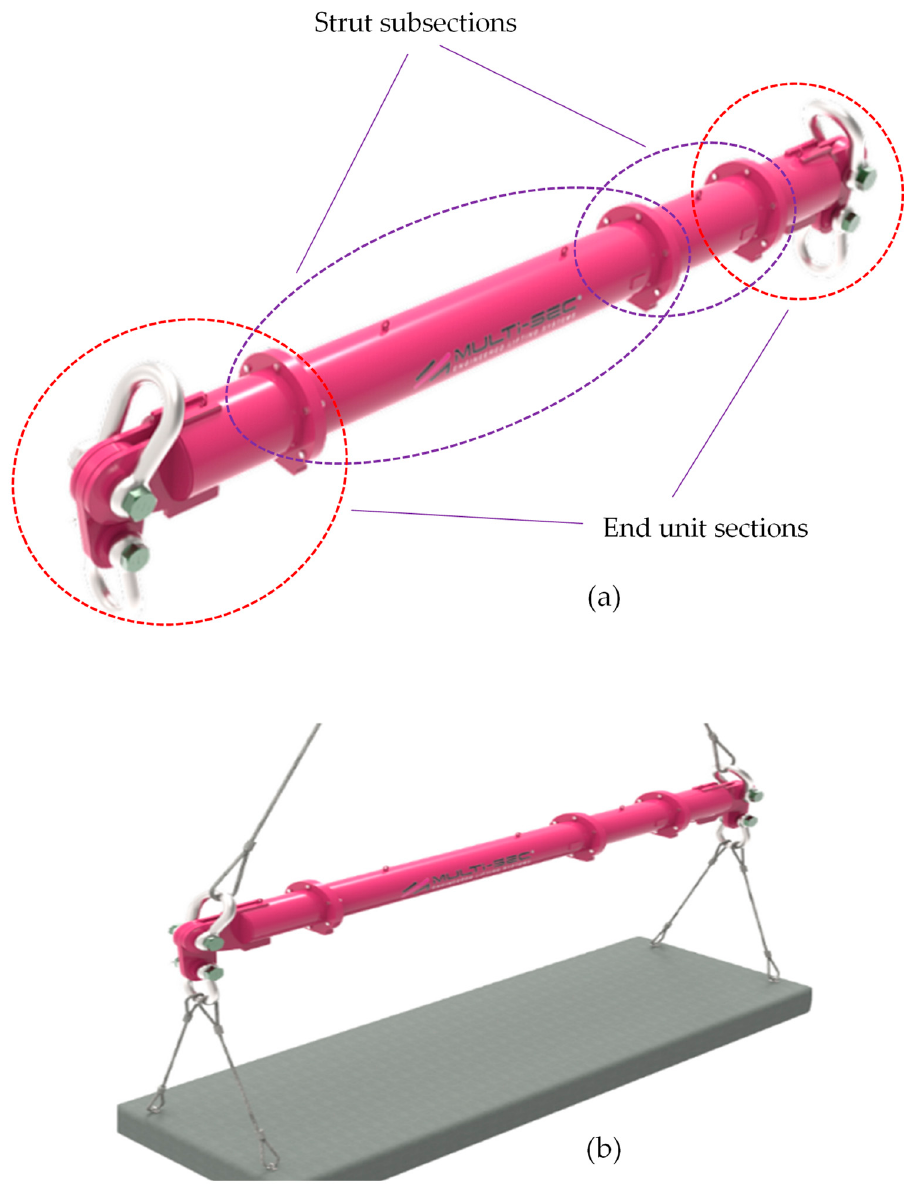
Figure 2. ( a ) A sample MultiSec spreader beam used in the Durham Lifting company; ( b ) the same beam in a typical lifting operation [2].